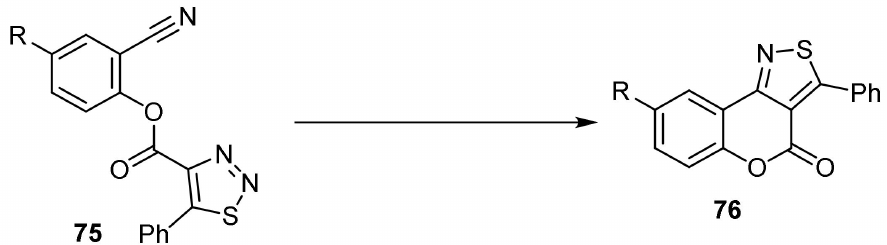
Scheme 22. Synthesis of 8-substituted-3-phenyl-4 H -chromeno[4,3- c ]isothiazol-4-ones 76 . Reagents and conditions. An amount of 5.0 mol% [Rh(COD)Cl] 2 , 12.0 mol% DPPF, PhCl (1.0 mL), N 2 , 80 ◦ C; R = H 90% yield; R = Me 99% yield; R = Br 90% yield.